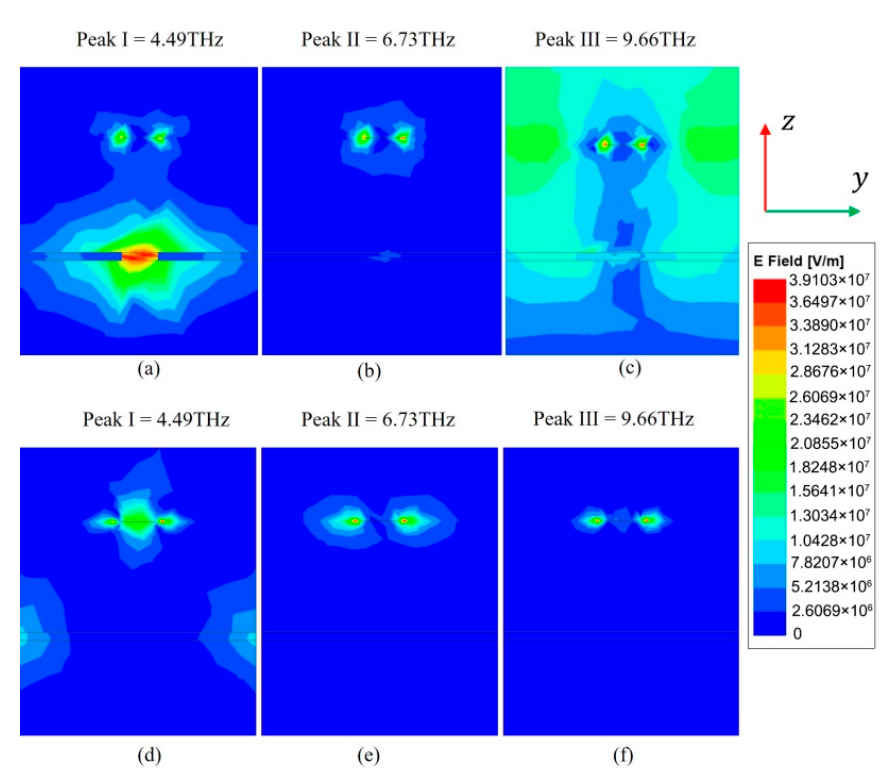
Figure 9. The absorption contribution rate of graphene, BDS and Al 2 O 3 in the proposed hybrid absorber.